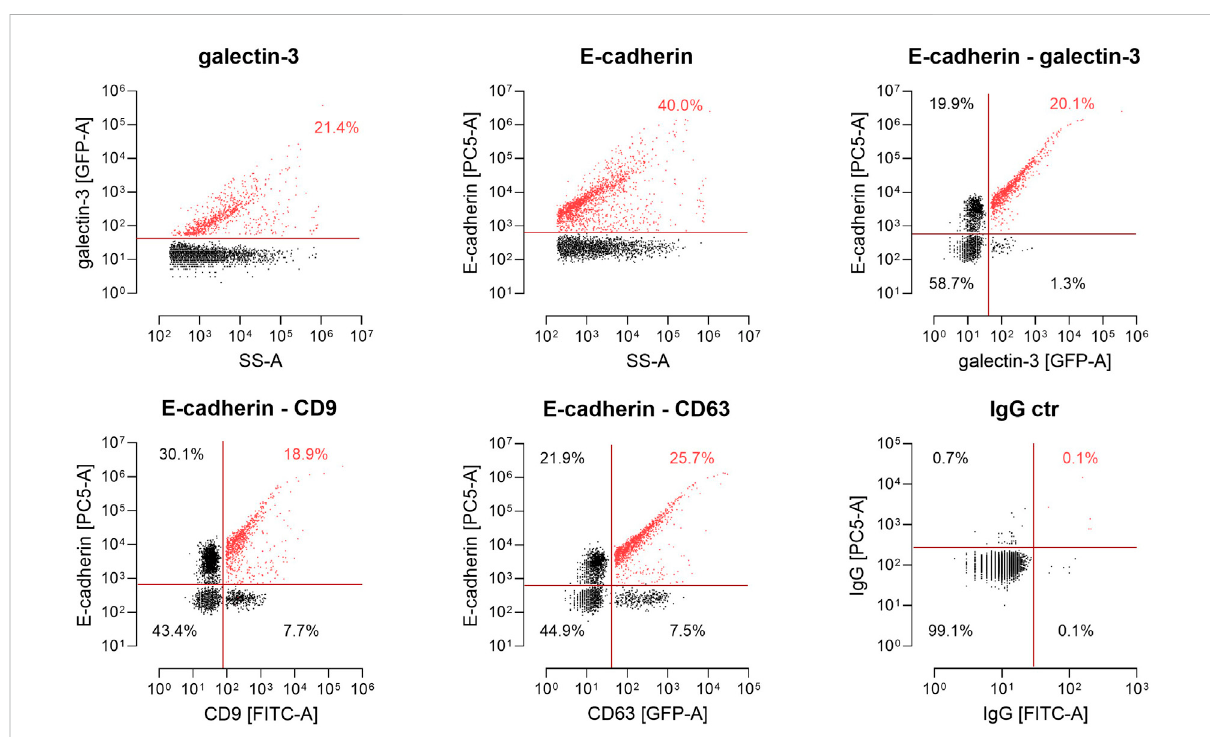
FIGURE 6 Single-particle phenotyping of EVs derived from MDCK Gal3-GFP cells. Representative plots of galectin-3-GFP and E-cadherin (Ecad) expression on single EVs using the GFP signal and PE-conjugated antibodies by nano- fl ow cytometry (nFCM).Bivariate dot-plots of indicated fl uorescence versus side scatter (SS-A). In addition, EVs harboring a CD63-GFP or fl uorescently labeled with FITC-conjugated antibodies speci fi c to CD9 were stained with PE-conjugated antibodies speci fi c to Ecad. For E-cadherin-detection on vesicle surfaces, the Genetex/Biozol antibody GTX134997 was used. Double positives for CD9/Ecad and CD63/Ecad are depicted. Fluorescently labeled IgG isotypes were used as a control. Numbers indicate events detected in the corresponding gate in percent of total